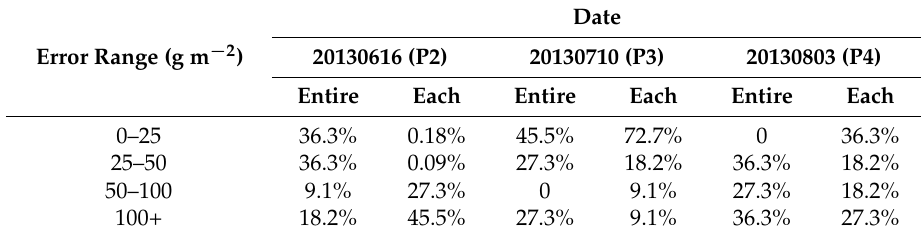
Figure 6. Biomass of 95 rape plots based on background images of quad-polarisation parameters used in their estimation models. ( A1 , B1 , and C1 ) are the estimation results with models of y = − 590.51x 2 + 1043.5x − 0.275 at the P2, P3, and P4 stages, respectively. The background images are the VOL parameter. ( A2 , B2 , and C2 ) are the estimation results of the regression models at each stage. The background images for A2 are lambda λ 1, for B2 it is ODD, and for C2 it is HH/VV. The unit is g m − 2 . Table 9. The proportion of plots within each estimation error range for biomass at each stage with entire growth cycle regression models and models built at the P2, P3, and P4 stages.